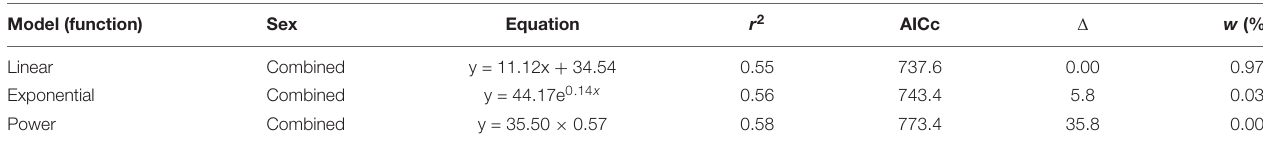
TABLE 2 | Relationship between the fork length (FL) and centrum radius (R) for the combined sexes of P. kamoharai caught in the Tropical Eastern Atlantic. Model (function)